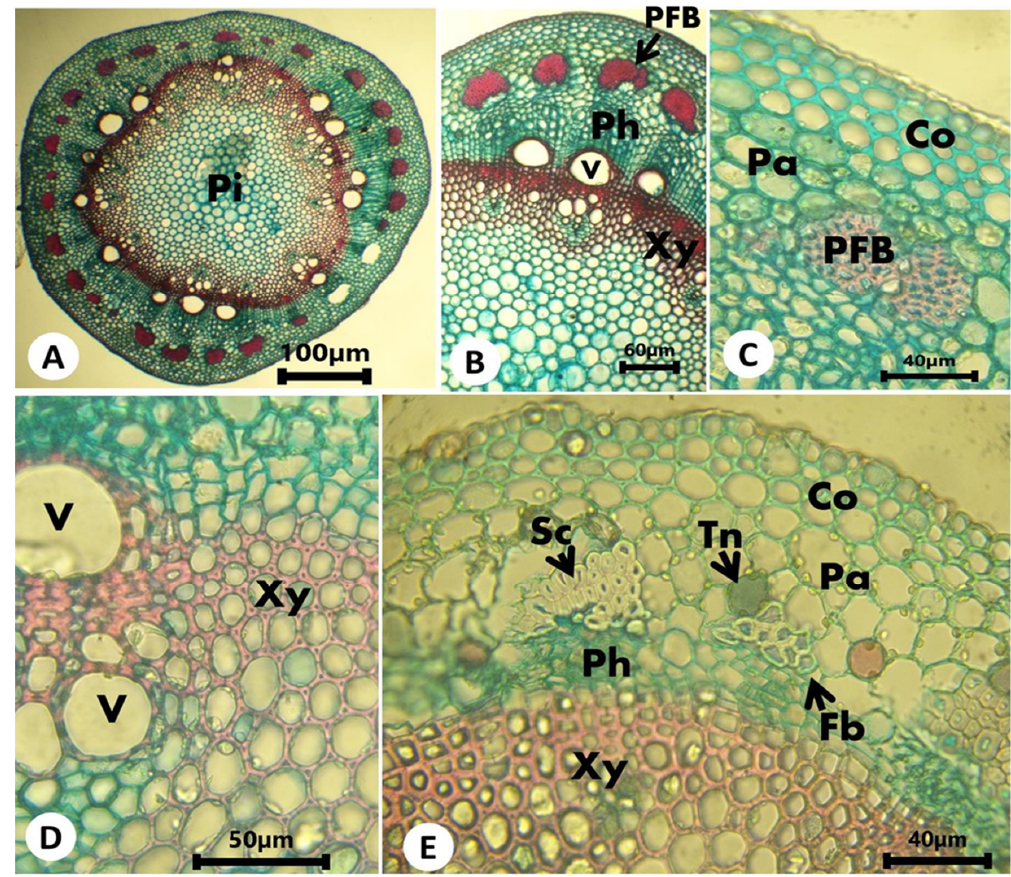
Figure 5. Transverse sections of midrib and lamina of Adenia species studied: (A-C) midrib of A. cissampeloides , (D – F) midrib of A. lobata, (G) Midrib of A. lobata (arrow shows stoma), (H) Lamina of A. cissampeloides , (I) lamina of A. lobata P = palisade mesophyll, Bs = Bundle sheath, S = spongy mesophyll, Dr = druse crystal, Pl = papillae, Sc = sclereid, Co = collenchyma, Pa = parenchyma, Dr = druse crystal, Ta = Tannin sack, St –